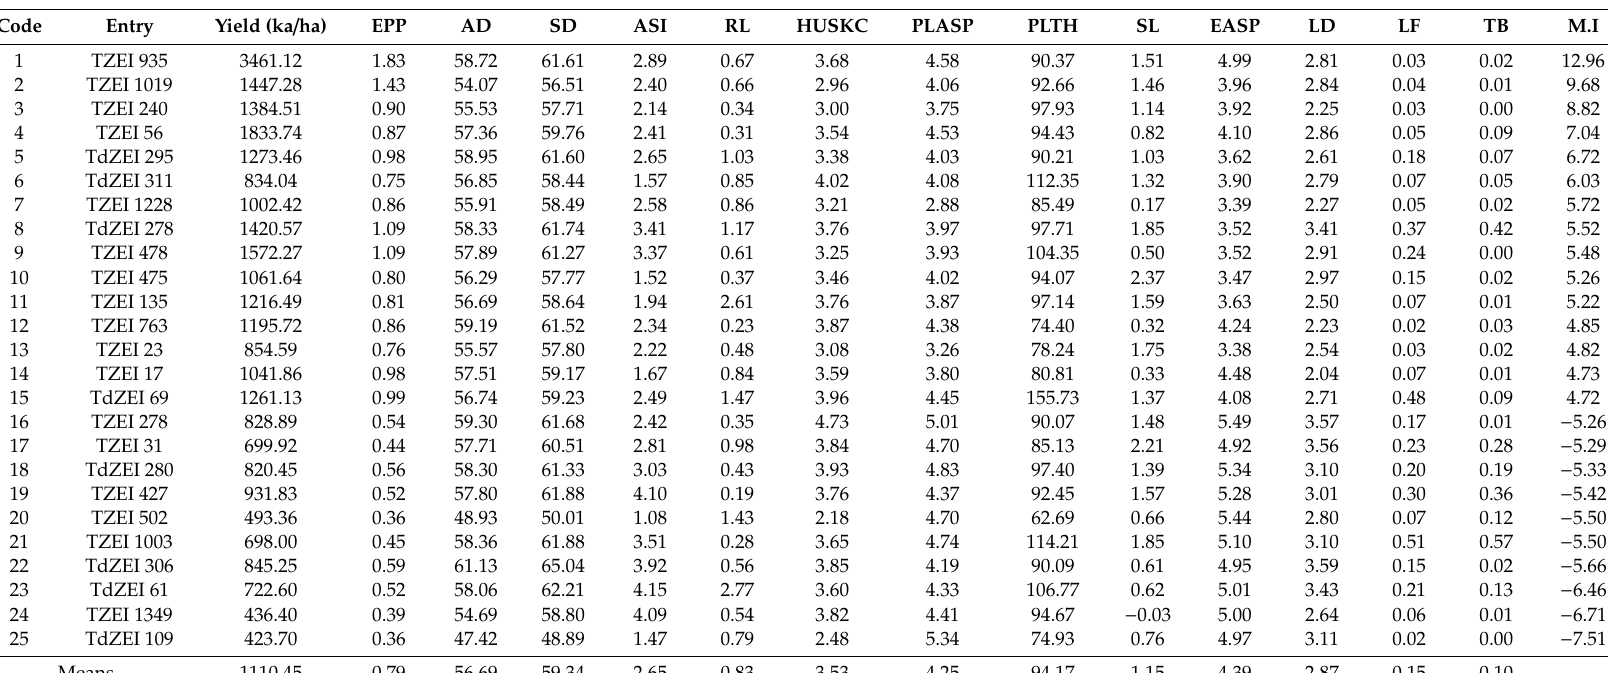
Table 4. Mean grain yield and other agronomic characters and codes of 25 selected inbred lines evaluated under combined heat and drought environments at Manga-Ghana and Kadawa-Nigeria during the 2018 and 2019 dry